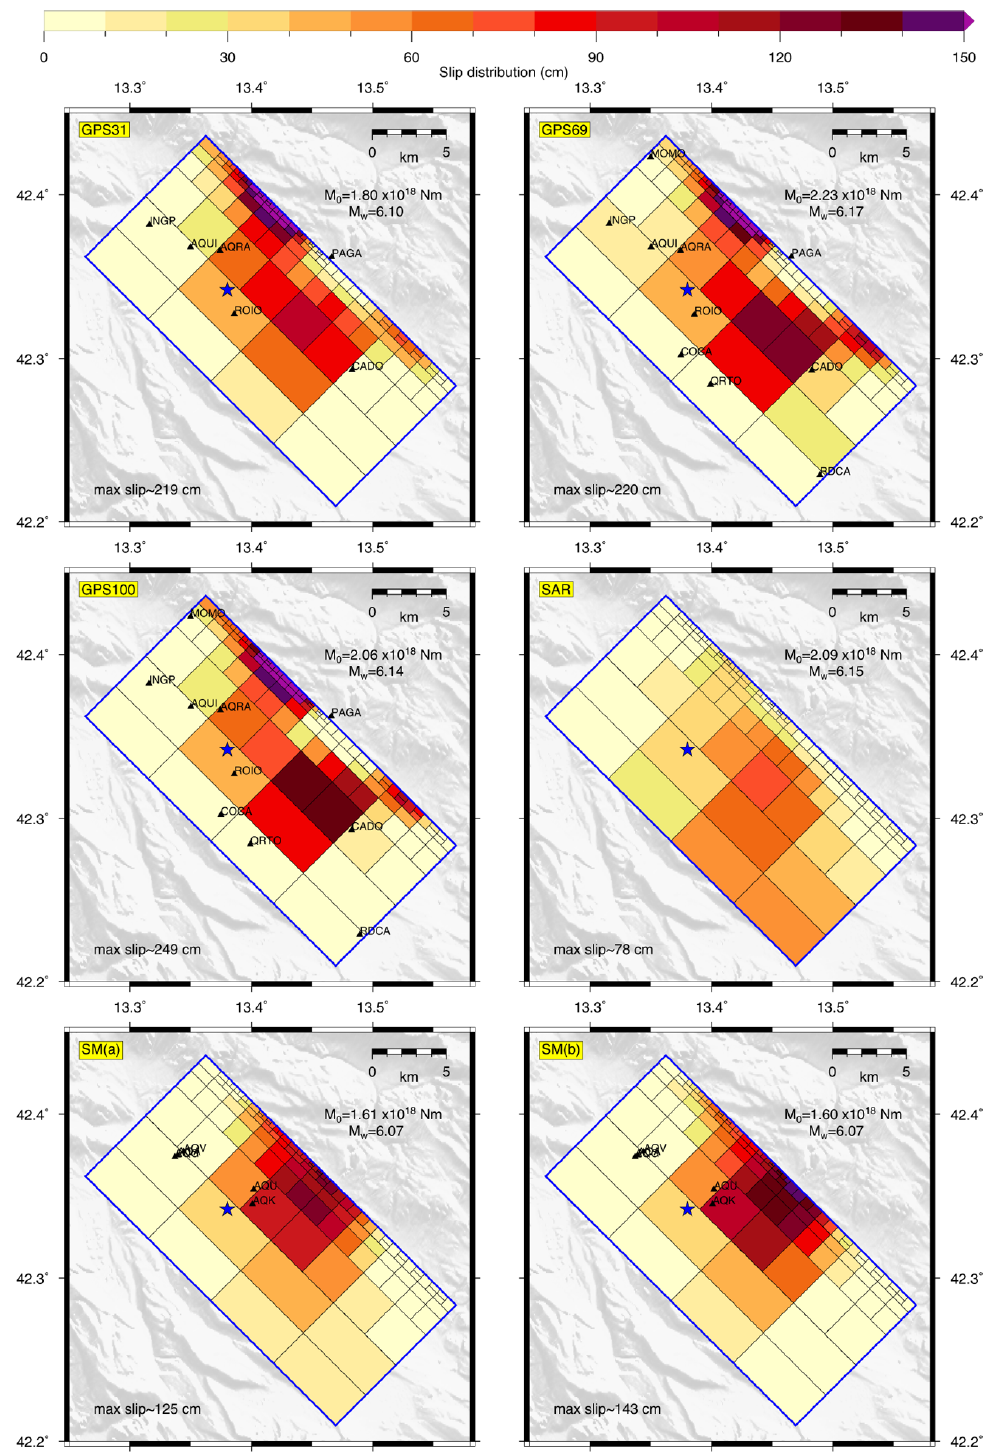
Figure 3. Source models obtained from the single inversions of GPS, InSAR and SM data. The seismic moment (M tude (M ) and the peak value of the slip release are shown. The blue star indicates the hypocenter. The GPS and SM stations contained w within the surface projection of the fault are also